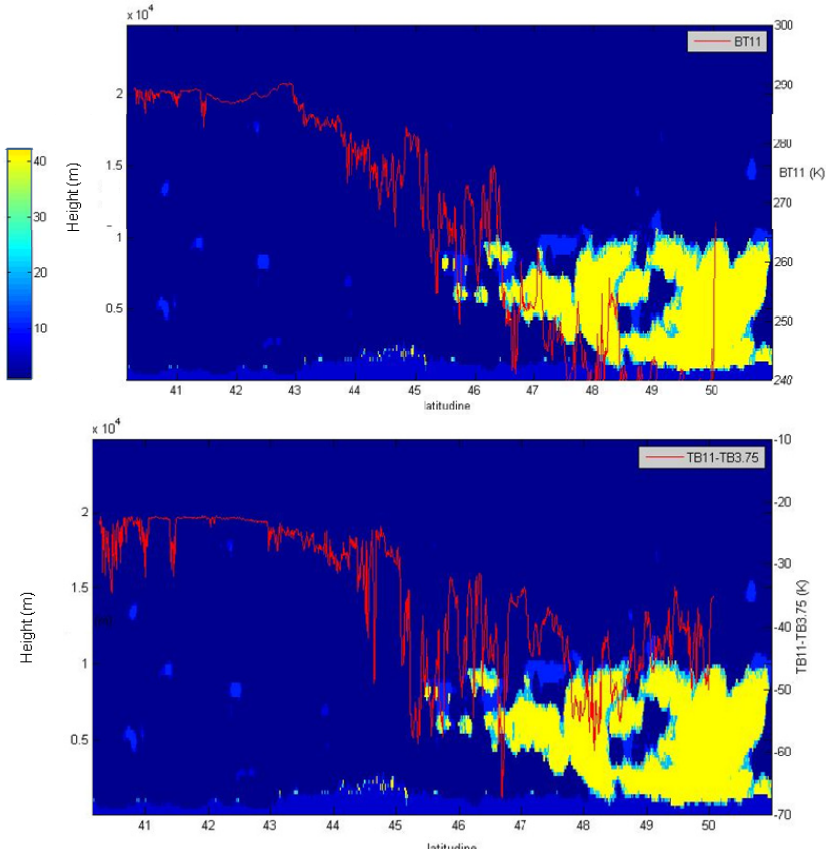
Figure 8. Bidimensional profile where the CloudSat profiles are compared with the values from test1 and 2 of MODIS cloud